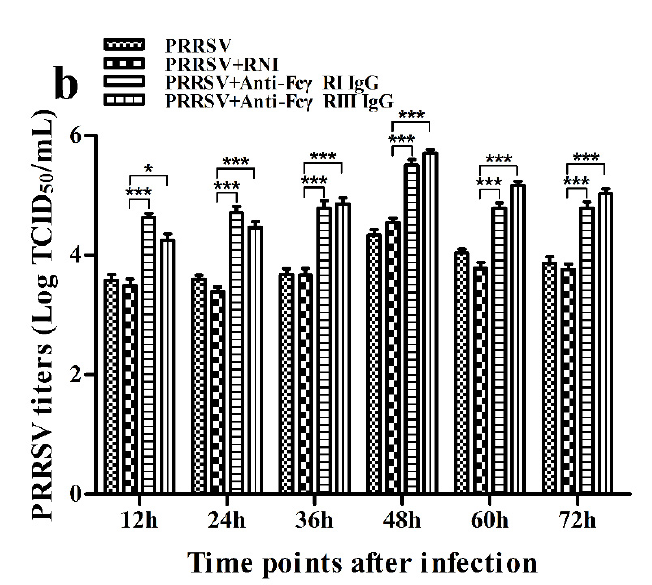
Figure 15. E ff ect of Fc γ RI or Fc γ RIII on PRRSV replication in porcine AMs. ( a ) Real-time RT-PCR analysis of PRRSV RNA copies in culture supernatants of PRRSV-infected cells pretreated with RNI, anti-Fc γ RI IgG or anti-Fc γ RIII IgG. ( b ) PRRSV titers in culture supernatants of PRRSV-infected cells pretreated with RNI, anti-Fc γ RI IgG or anti-Fc γ RIII IgG from three independent experiments were measured in Marc-145 cells and expressed as TCID 50 / mL. *** p < 0.001, ** p < 0.01, * p < 0.05.